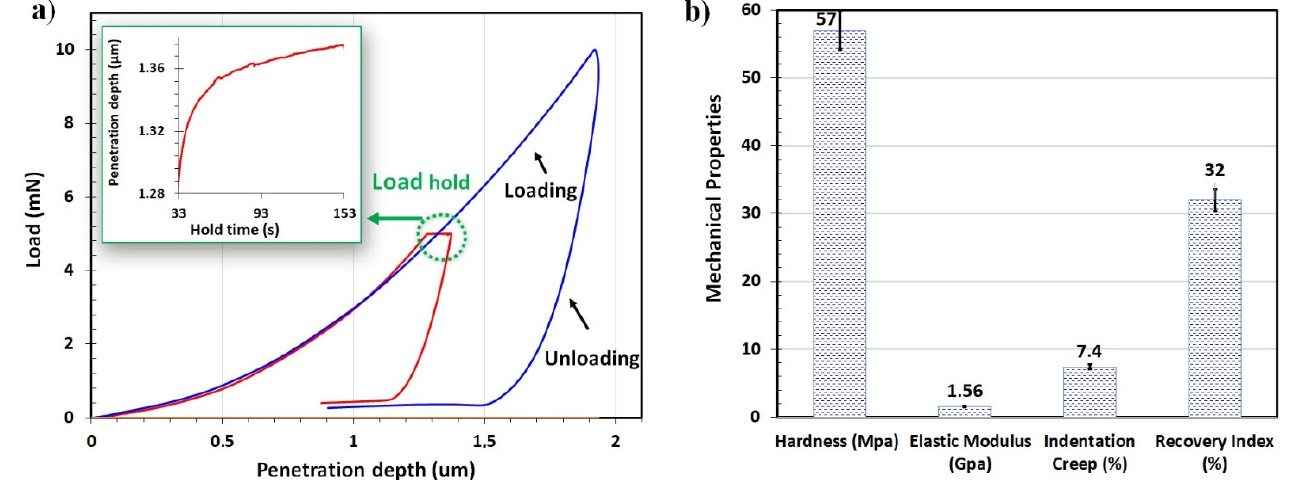
Figure 3. (a ) Load–depth curves for FEP coatings with 5 and 10 m N maximum load and ( b ) measured values from nanoindentation tests on FEP coatings.